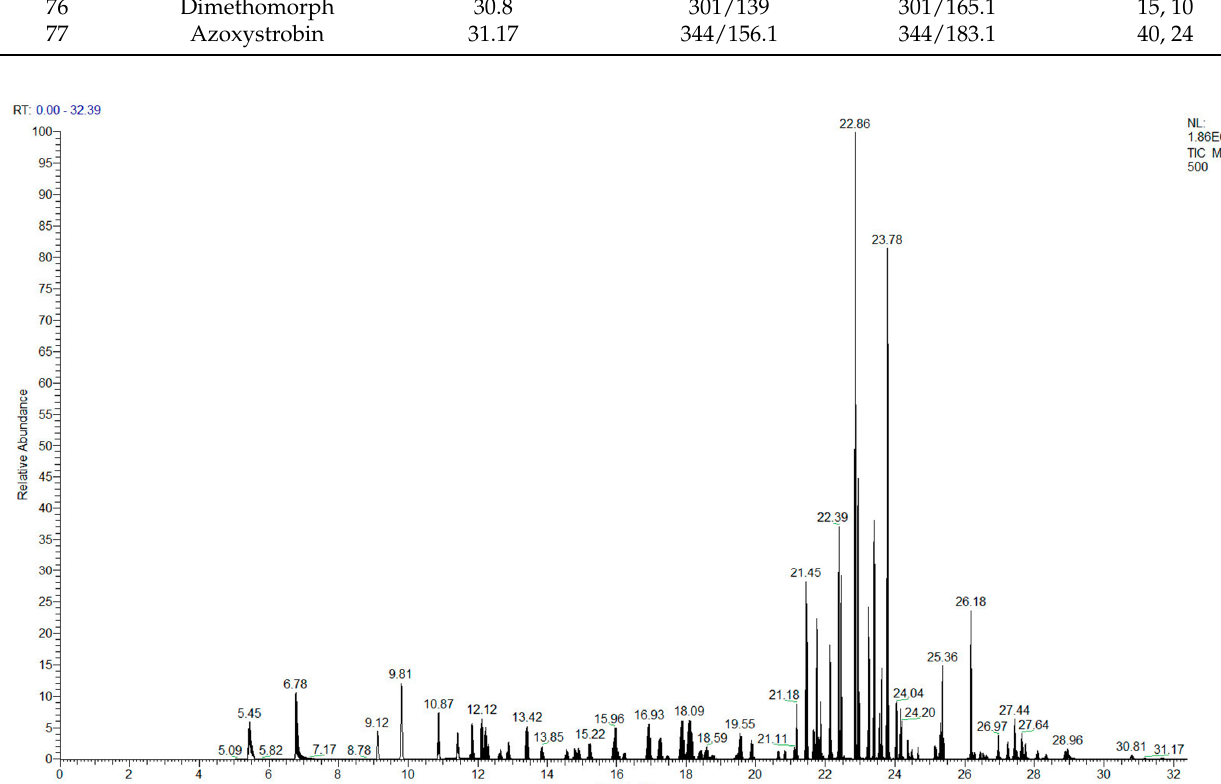
Figure 2. Total ion chromatogram (TIC) of 77 pesticides in red ginseng. 3.2. Linearity, Limits of Detection (LODs) and Limits of Quantification (LOQs) Both external and internal standard methods are commonly used in pesticide residue analysis, and each has advantages and disadvantages. matrix external standard method was used in this study, which could meet the requirements of residue analysis methods, while also avoiding the disadvantages of the internal standard being more difficult to